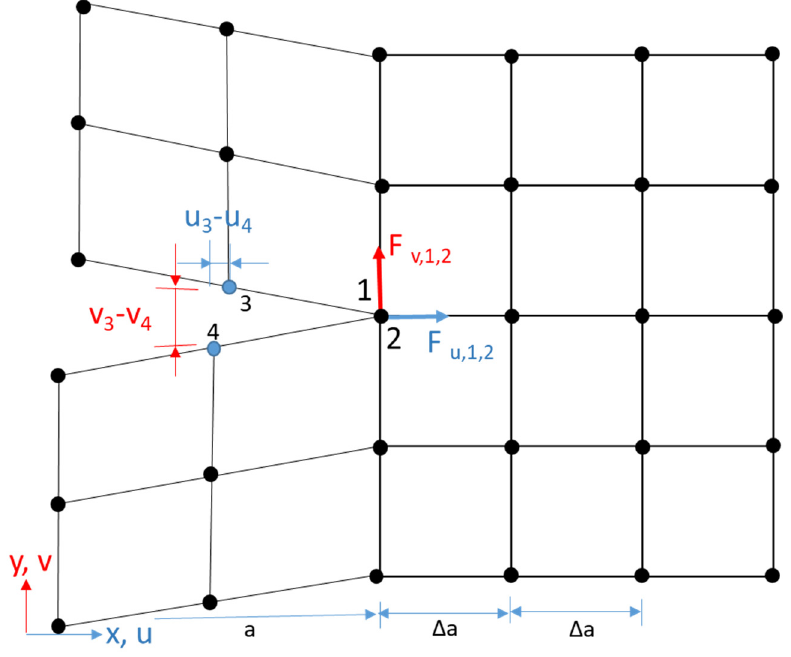
Figure 2. Schematic representation of the VCCT reasonable for the quadrilateral element with four nodes.